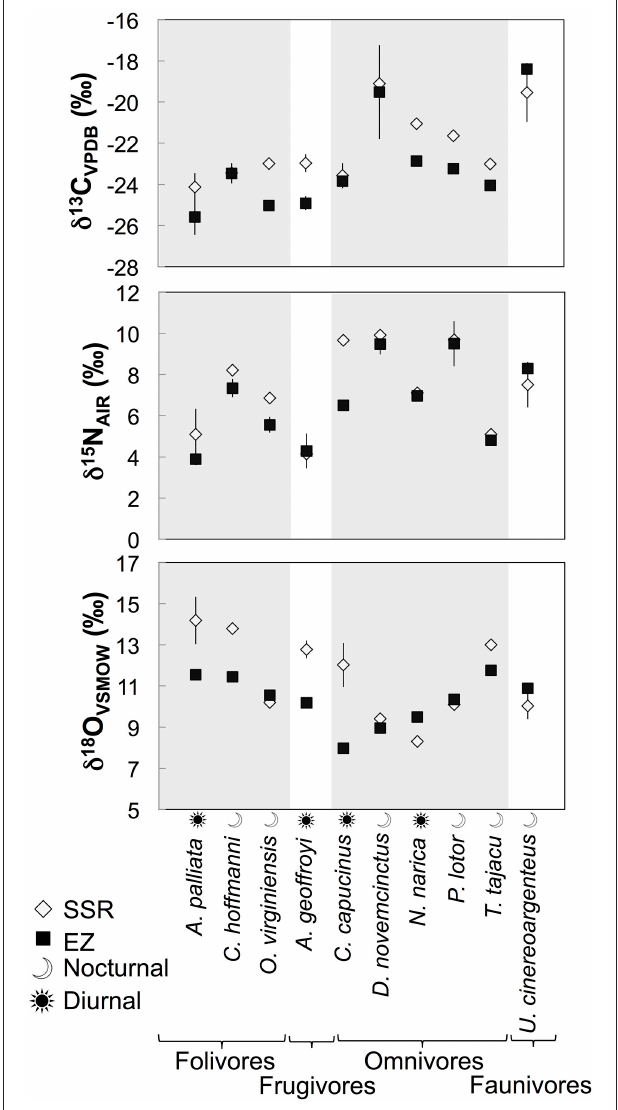
FIGURE 2 | Average δ 13 C, δ 15 N, and δ 18 O values ( ± 1 σ ) for the 10 species that were sampled at both Sector Santa Rosa and El